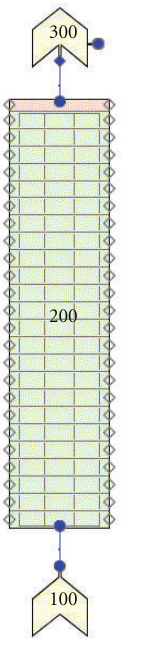
Figure 4: TRACE representation of the heated test section.